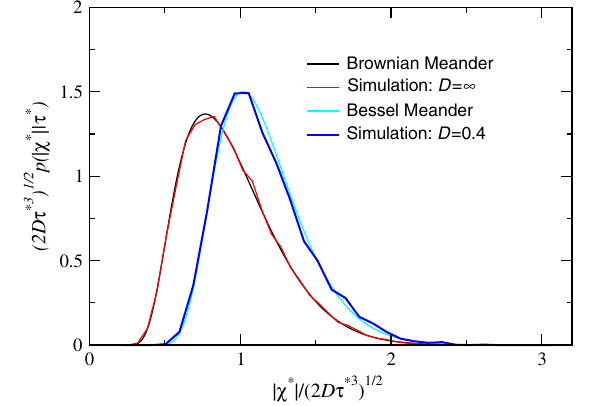
FIG. 14. The conditional PDF of the area under the Bessel ( D ¼ 2 = 5 ) and Brownian ( D → ∞ ) meanders, Eq. (E15). For D ¼ 2 = 5 , we used five-term summation in Eq. (E15), with a 1 ¼ 0 . 849 , a 2 ¼ − 0 . 314 , a 3 ¼ 0 . 535 , a 4 ¼ − 0 . 3072 , a 5 ¼ 0 . 441 ~ d and the values of in Table I. The simulation method is outlined k in Appendix D, and we averaged over 2 × 10 5 samples with τ ¼ 10 5 . The theoretical curve was plotted with